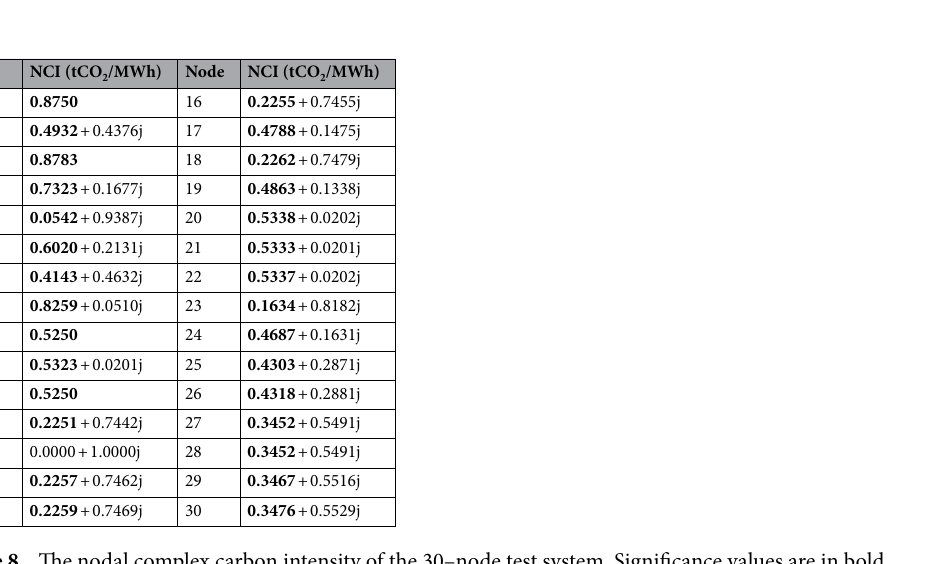
Table 8. The nodal complex carbon intensity of the 30–node test system. Significance values are in